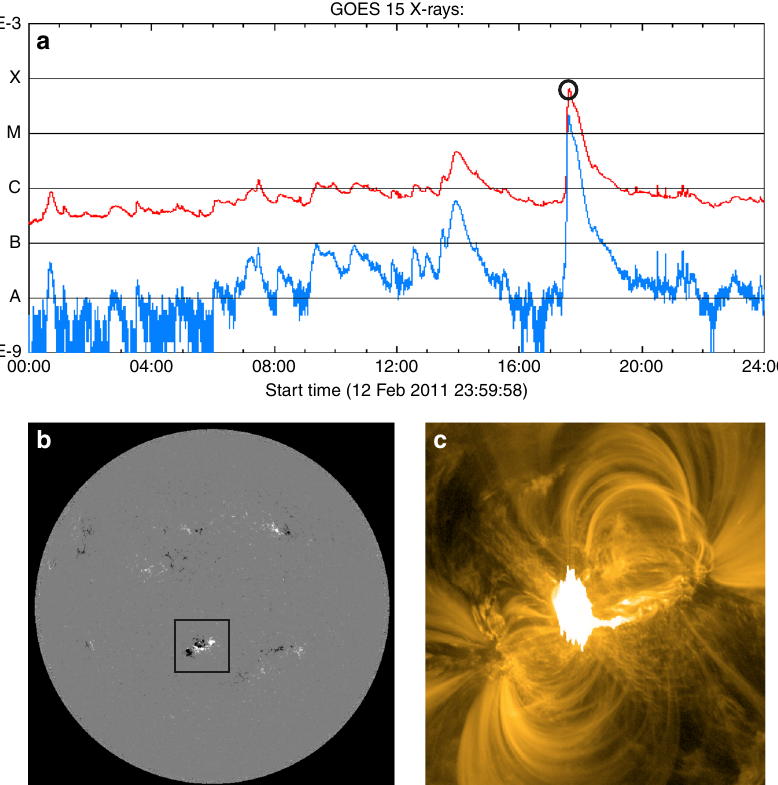
Fig. 1 M6.6 class solar fl are observed on 2011 February 13. a Time pro fi le of the X-ray fl ux measured by the GOES 12 satellite on February 13. The M6.6 class fl are marked by the open circle started at 17:28 UT and the peak was observed at 17:30 UT. The solar X-ray outputs in the 1 – 8 and 0.5 – 4.0 Å passband are plotted, respectively. b The line-of-sight magnetic fi eld of whole sun observed at 17:48 UT taken from SDO/HMI. The cluster of the magnetic fl ux surrounded by the black square corresponds to the AR11158 producing the fl are. c , EUV 171 Å image of the M6.6-class solar fl are taken by SDO/AIA observed at 17:45